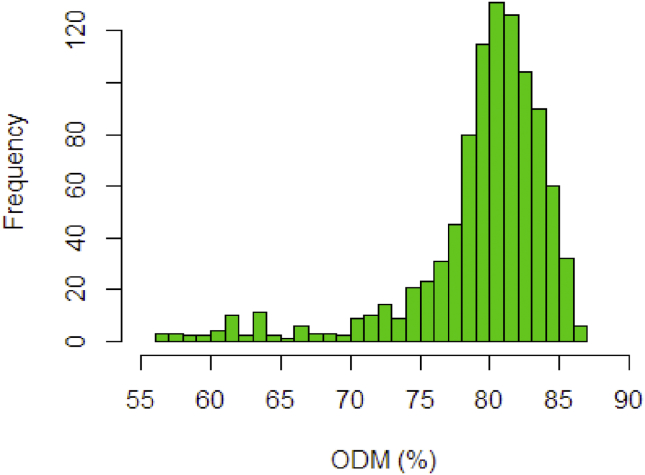
Frequency distribution histogram of %ODM values.